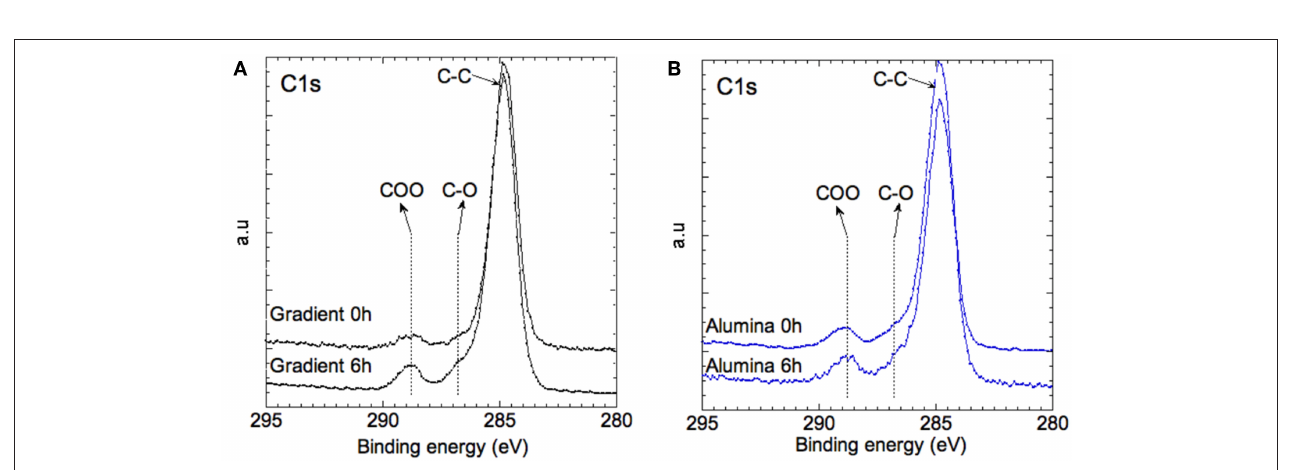
FIGURE 5 | XPS spectra of the C1s core level of (A) the gradient shell sample and (B) the aluminum treated sample at 0 and 6h of aging.